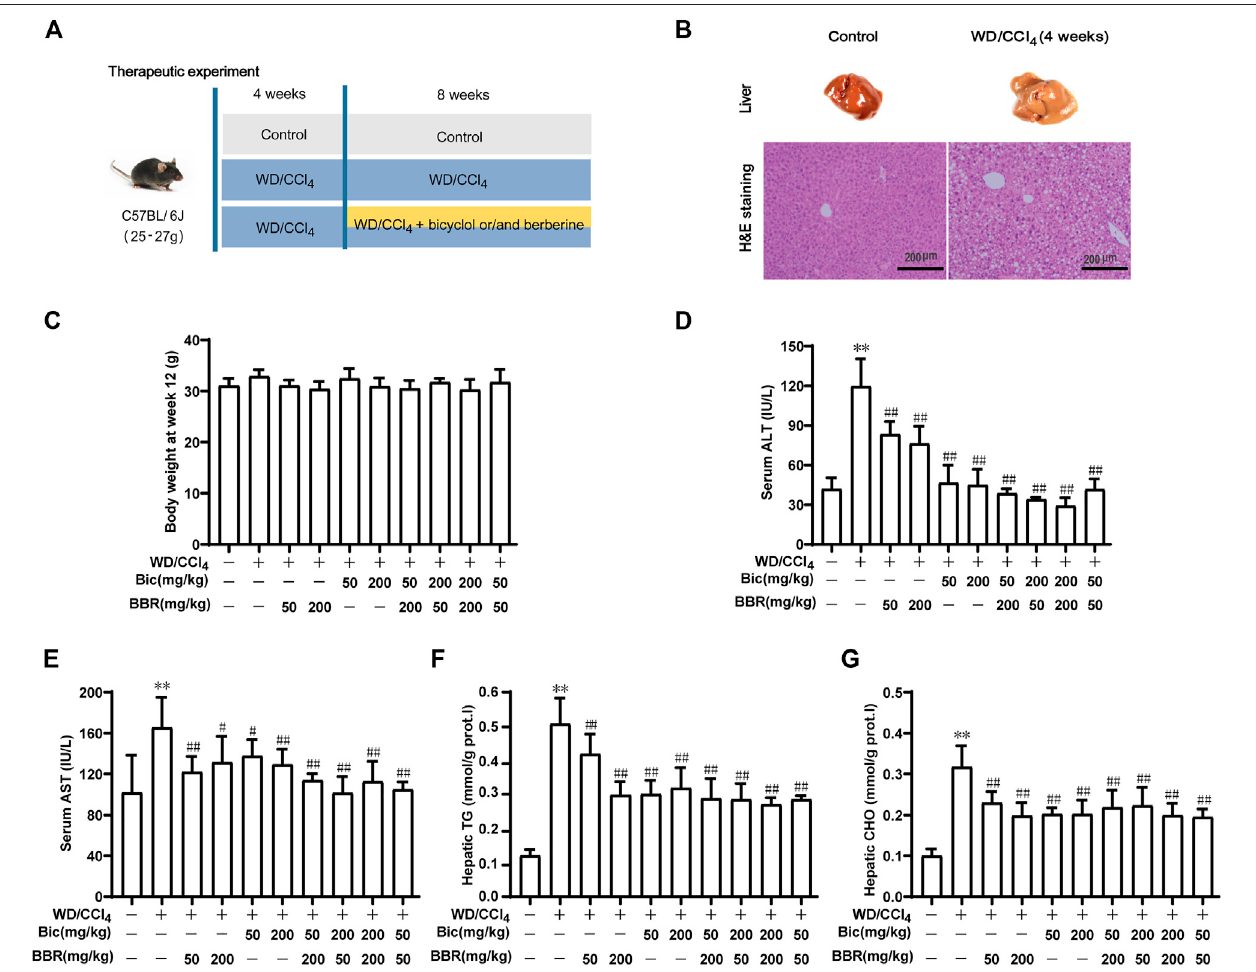
FIGURE2| CombinationofbicyclolandberberinedemonstratesbettertherapeuticeffectsonNASHinmiceinducedbyWD/CCl 4 .MaleC57BL/6Jmicewerefreely fed withWesterndietplus intraperitonealinjection of0.2 ml/kg CCl 4 (WD/CCl 4 )once per weekfor 4 weeks (A) .LiversteatosiswasperformedwithH&Estainingat week 4 (B) . Then the mice were continuously treated with WD/CCl 4 or WD/CCl 4 plus drug for 8 weeks. Thebodyweight (C) wasrecorded. ALT (D) and AST (E) in serum and TG (F) andCHO (G) intheliverweremeasured.LiverhistopathologywasevaluatedusingH&E,ORO,andMasson ’ strichromestaining (H) andquanti fi edwithNAS score criteria (I) and fi broticsurface (J) .Resultswerepresentedasmean±SD.n =5 – 9foreach group,*p < 0.05and **p < 0.01, WD/CCl 4 -inducedmodelgroupvs. the control group; # p < 0.05 and ## p < 0.01 vs. the WD/CCl 4 -induced model group or monotherapy